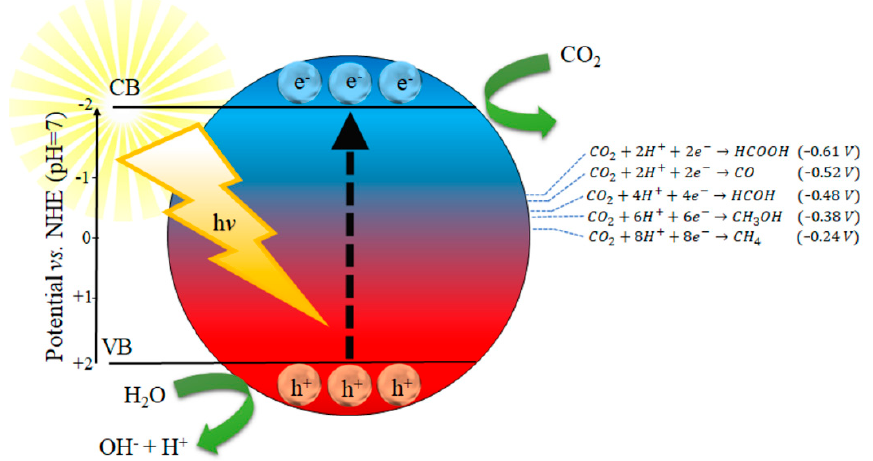
Figure 1. Schematic illustration of the photocatalytic CO 2 reduction to different solar fuels and their reduction potentials.